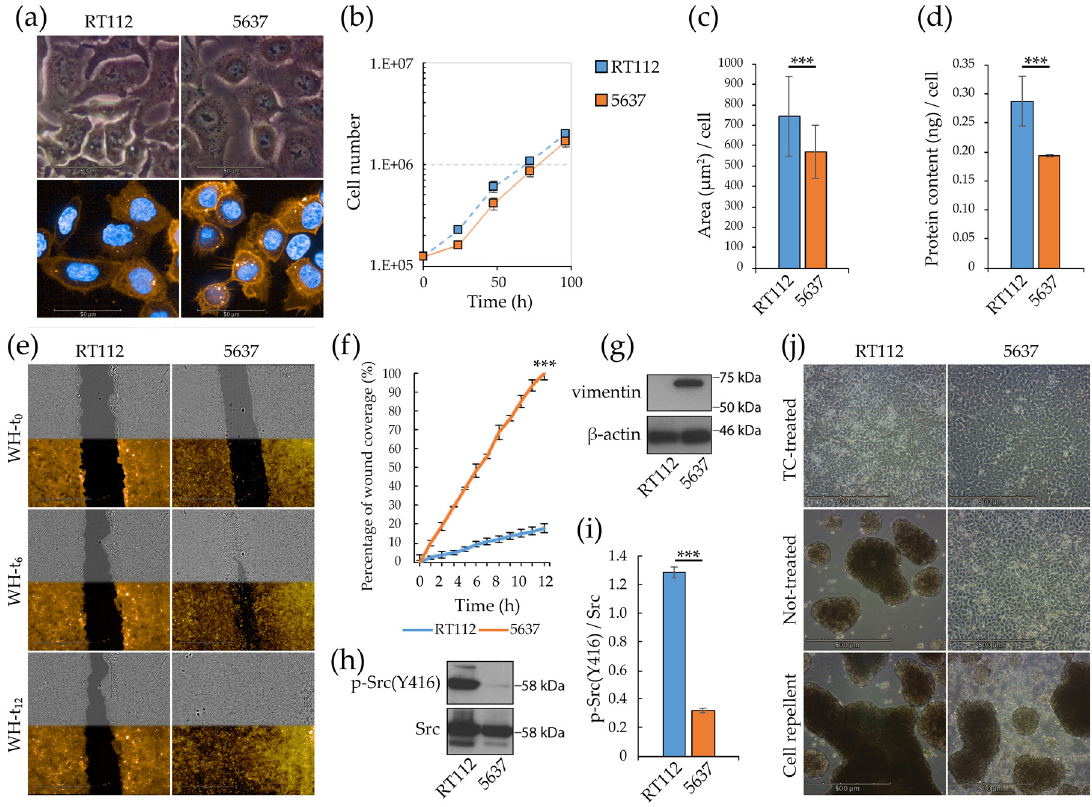
Figure 1. Morpho / functional readouts of RT112 and 5637 cells: proliferation rate, migration and spheroids formation capacity. ( a ) RT112 and 5637 cell morphology by phase contrast and confocal microscopy. For confocal microscopy cell membranes and nuclei were stained with fluorescent Vybrant ™ DiI Cell-Labeling Solution (orange) and Hoechst 33342 (blue) dye respectively. ( b ) RT112 and 5637 cell growth curves in standard medium. Viable cells were counted by the Trypan-Blue exclusion method. ( c ) RT112 and 5637 average cell surface area measured as Vybrant ™ fluorescent area using Harmony software. ( d ) RT112 and 5637 average protein content per cell measured by Bradford assay. ( e ) Representative wound healing assay images acquired by brightfield and fluorescence microscopy with Operetta CLS ™ at 0 h, 6 h and 12 h after scratch (orange: CellTracker ™ Red CMTPX Dye). ( f ) Percentage of wound coverage in wound healing assay through time (0–12 h), measured using Harmony software. ( g , h ) Western blot analysis for vimentin ( g ) and for Src and p-Src(Y416) ( h ) proteins in RT112 and 5637 cells. ( i ) p-Src(Y416) / Src ratio in RT112 and 5637 cells measured after densitometric analysis of Western Blot bands with ImageJ. ( j ) Spheroids formation assay in di ff erent supports: tissue culture treated (upper panels), not-treated (middle panels) and cell repellent supports (lower panels). Images were acquired in phase contrast light microscopy. Results are the mean of two ( f ) or three ( b – d , i ) experimental replicates. Statistical test: t -test and linear regression, *** for p < 0.001.